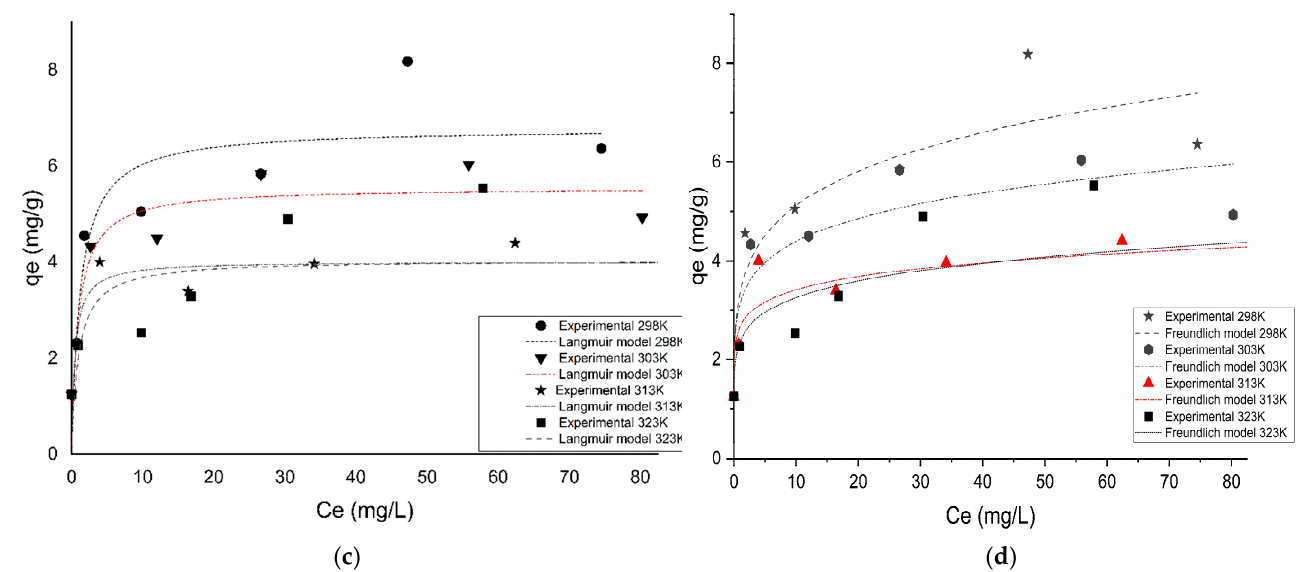
Figure 10. ( a , b ) As 3+ for Langmuir and Freundlich isotherm model plots; ( c , d ) F − for Langmuir and Freundlich isotherm model plots. Table 5. Non-linearized adsorption isotherm values of F − and As 3+ onto the Fe-pPD composite. Langmuir Freundlich Langmuir